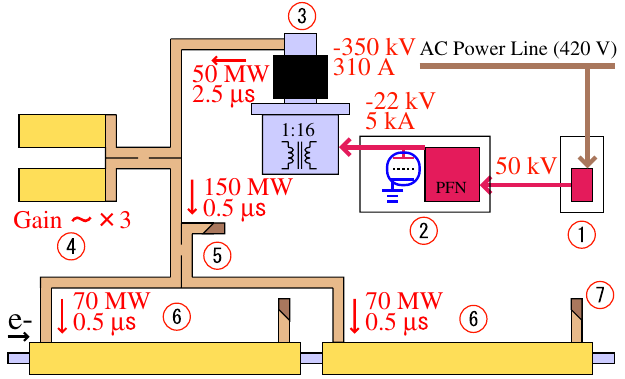
FIG. 2. (Color) Schematic representation of the C-band accel- erator unit. The rf power values in the figure are for nominal acceleration gradient of 35 MV = m . 1, inverter high-voltage power supply; 2, compact oil-filled modulator; 3, 50-MW C- band klystron; 4, rf pulse compressor; 5, 3 dB hybrid coupler; 6, choke-mode type accelerating structure; and 7, dummy